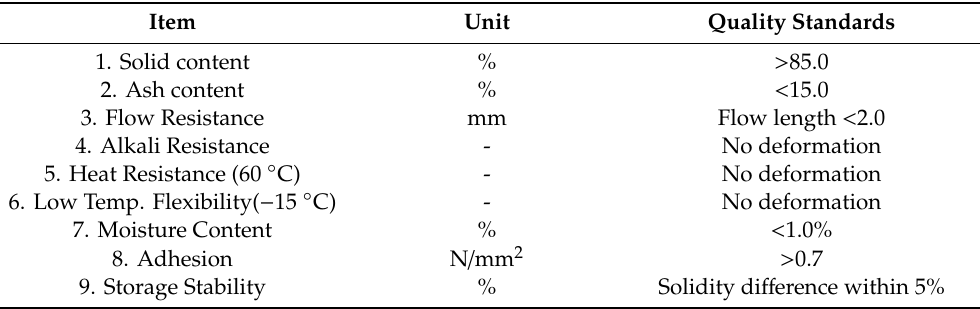
Table 2. LH Construction issued Specification for Performance Standard of